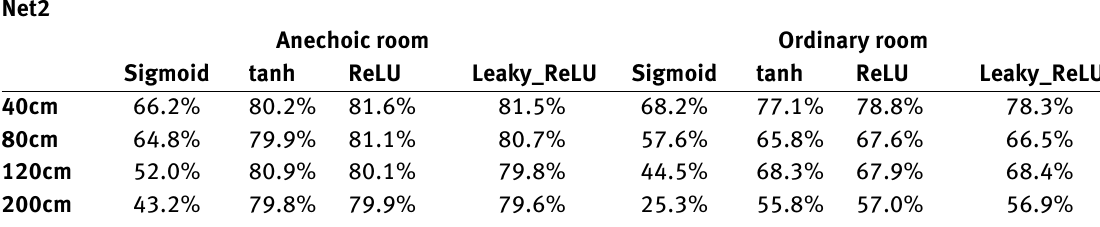
Table 4: Experimental results based on Net2.